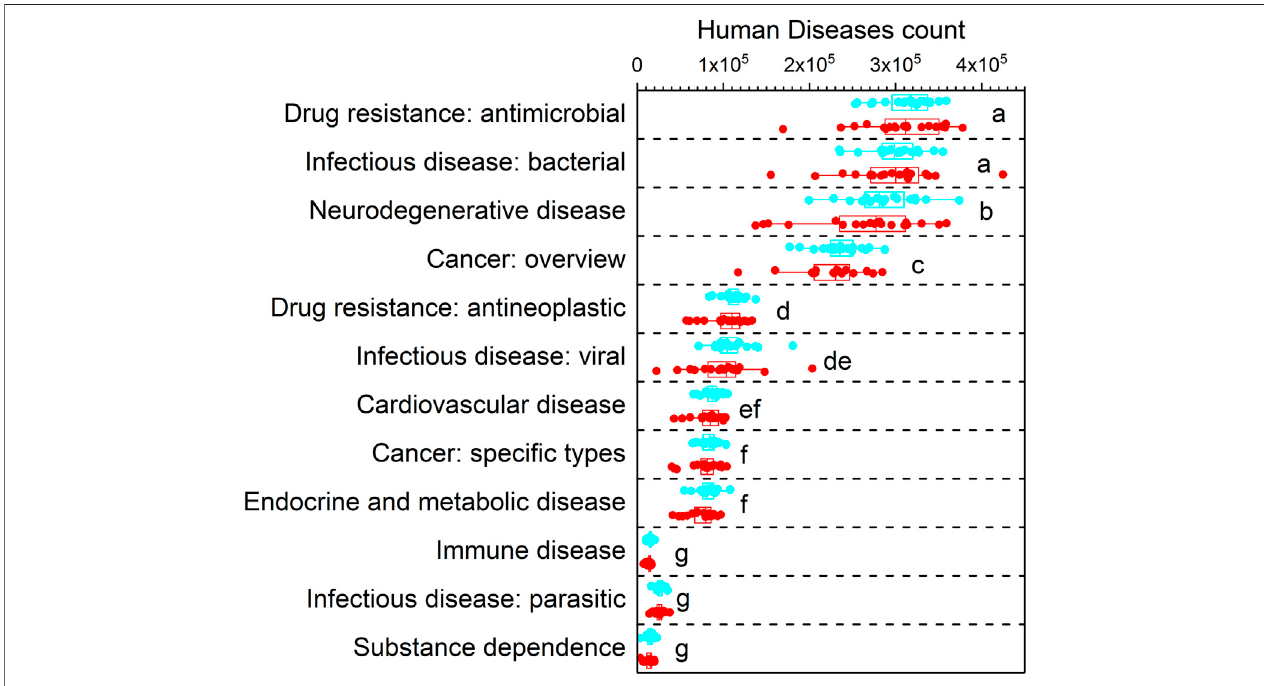
FIGURE 4 | The predictive functions at level 2 in dust samples. Cyan showed the human diseases count in respirable dust and red showed the human diseases count in total dust. Different lowercase letters were signi fi cantly different from each other ( p < 0.05, TukeyHSD).